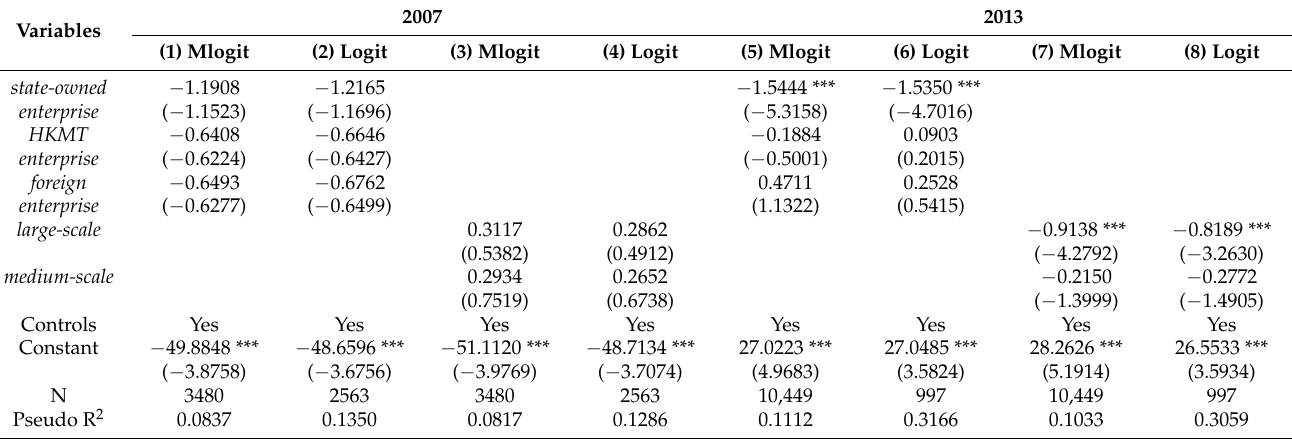
Table 15. Regression results of logit model for